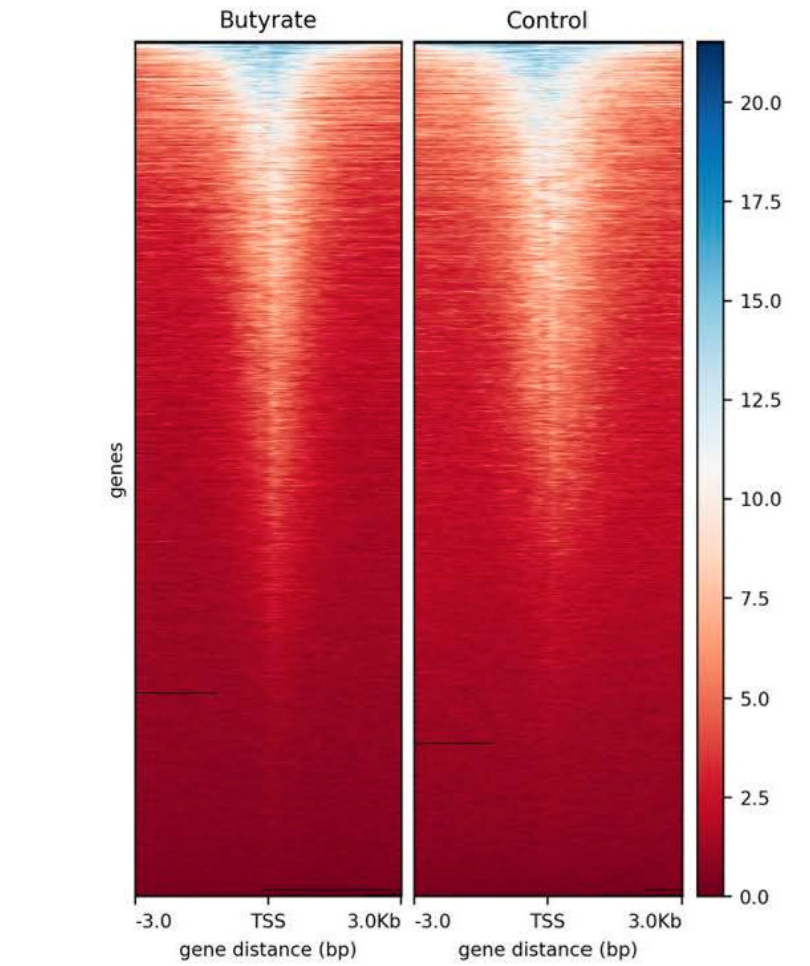
Figure 1. Heatmap profile of CTCF peaks relative to the transcription start sites (TSS) considering a ± 3 kb region for each pool with two samples each (considering chromosomes 1–29). Blue color intensity reflects the level of peak enrichment, and black lines are missing data. BT: butyrate. CT: control.